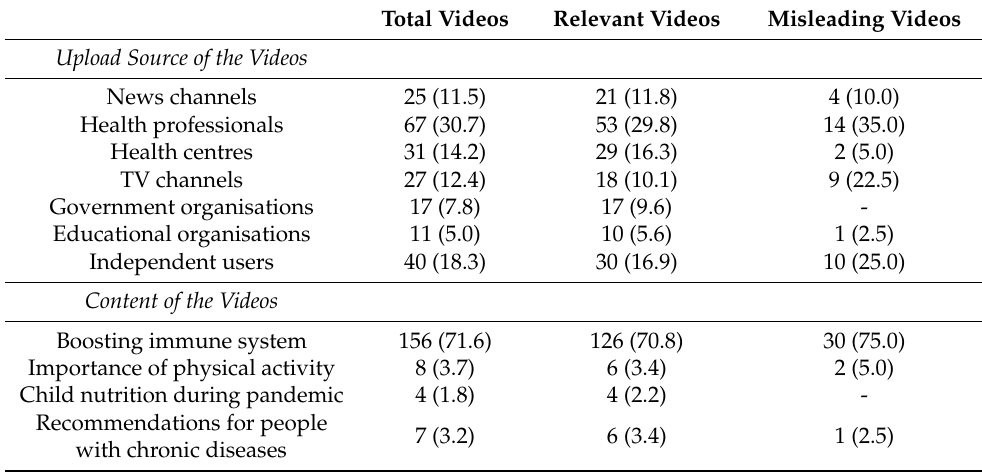
Table S10 shows the correlation between different scoring systems. There was a positive association between mDISCERN score and AVQ with other scoring systems. Table 2. Source and content wise distribution of videos ( n = 218).